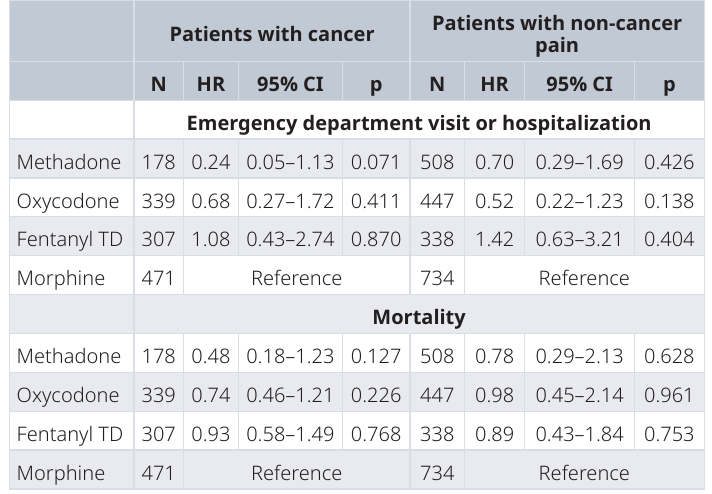
Table 3. Observational comparative 4 cohort study.